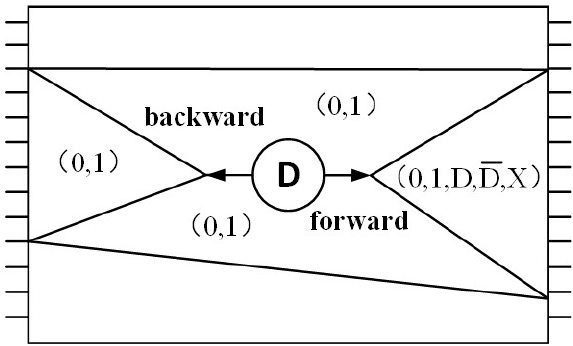
Figure 1. D algorithm schematic diagram.